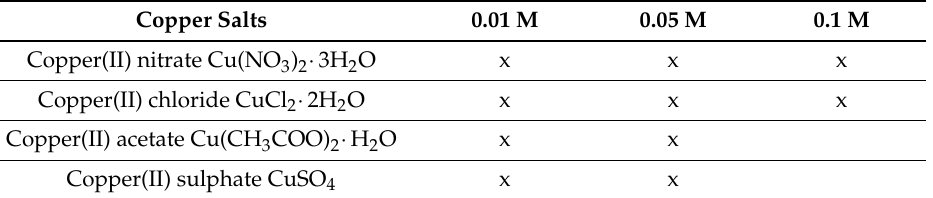
Table 1. Investigated conditions of